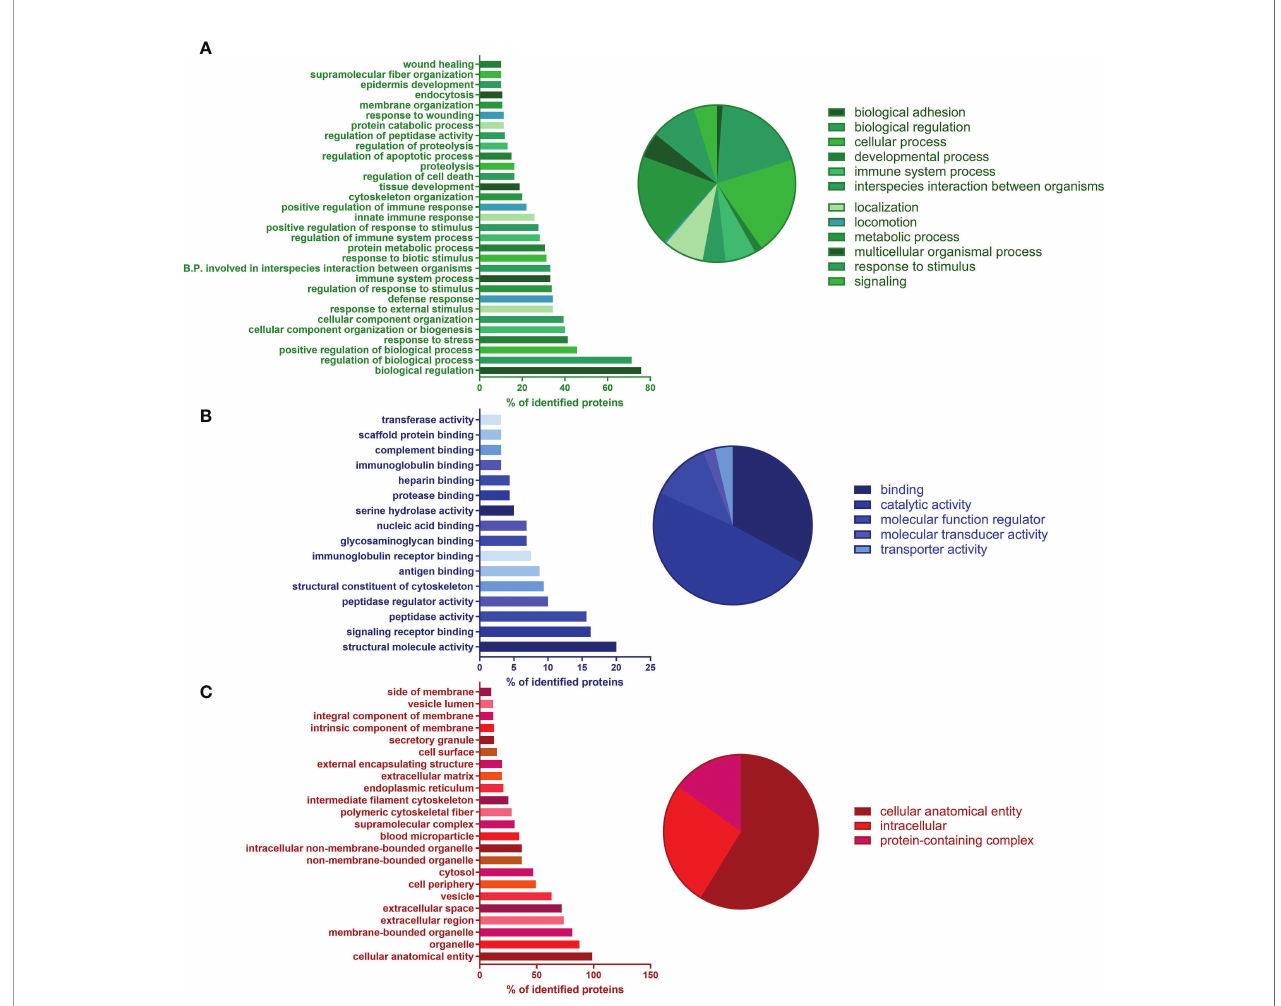
FIGURE 3 | Proteomics of ChipEXO; Gene Ontology (GO) analysis according to functional enrichment networks: (A) biological process (green), (B) molecular function (blue), and (C) cellular component